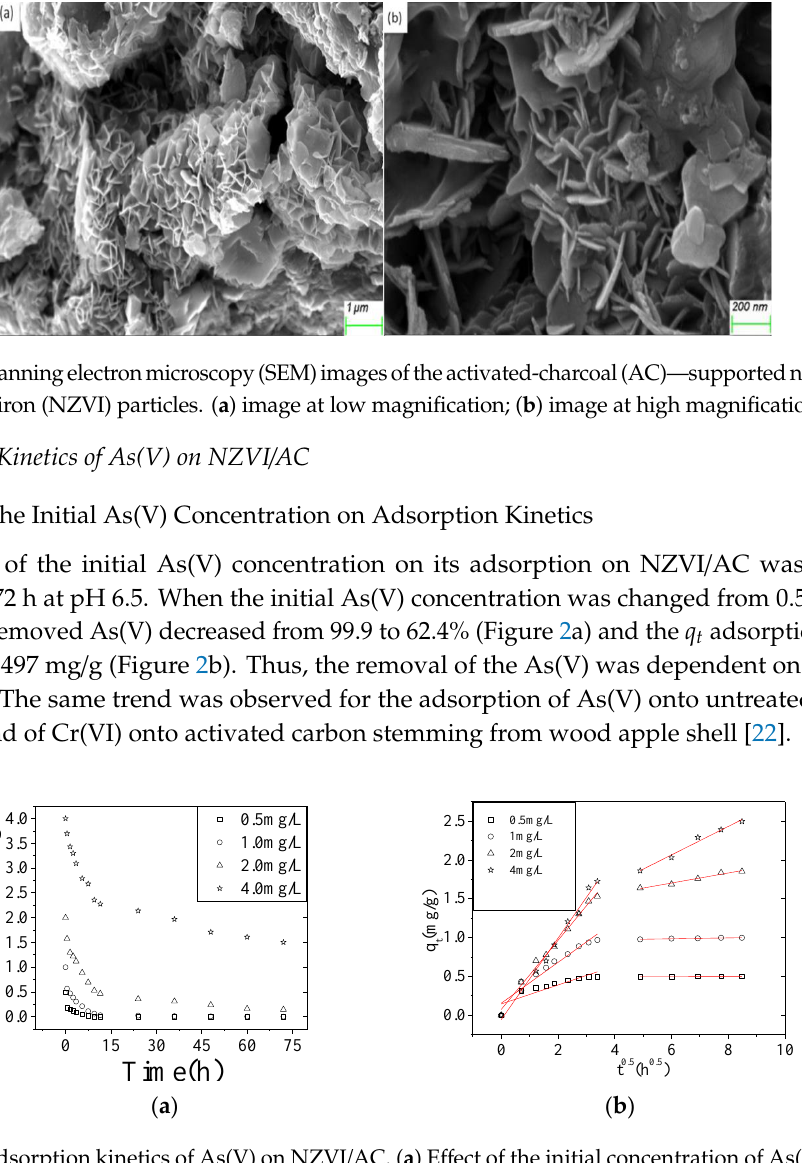
Figure 1. Scanning electron microscopy (SEM) images of the activated-charcoal (AC)—supported nanoscale zero-valent iron (NZVI) particles. ( a ) image at low magnification; ( b ) image at high magnification.